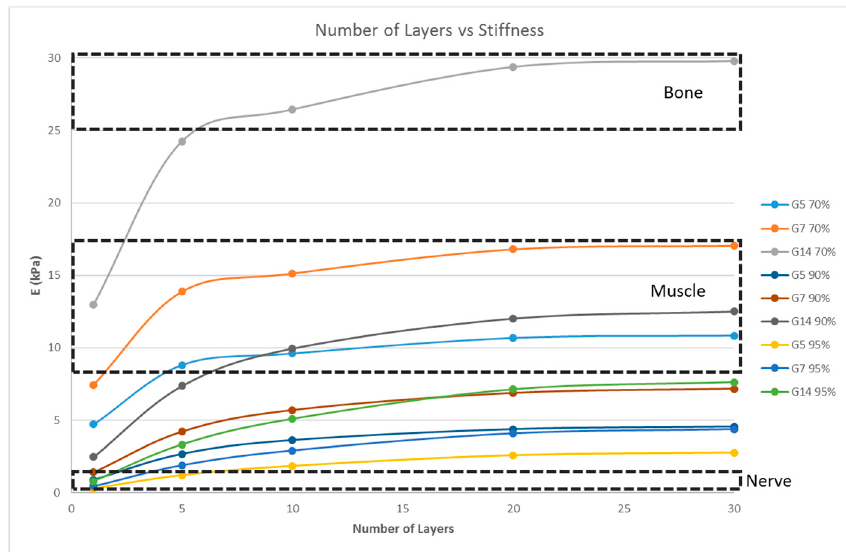
Figure 6. Effect of the number of layers on the stiffness of the structure with a fixed unit cell pore side length ( p = 200 μ m) at three different porosity values (70%, 90%, 95%) for G5, G7, and G14.